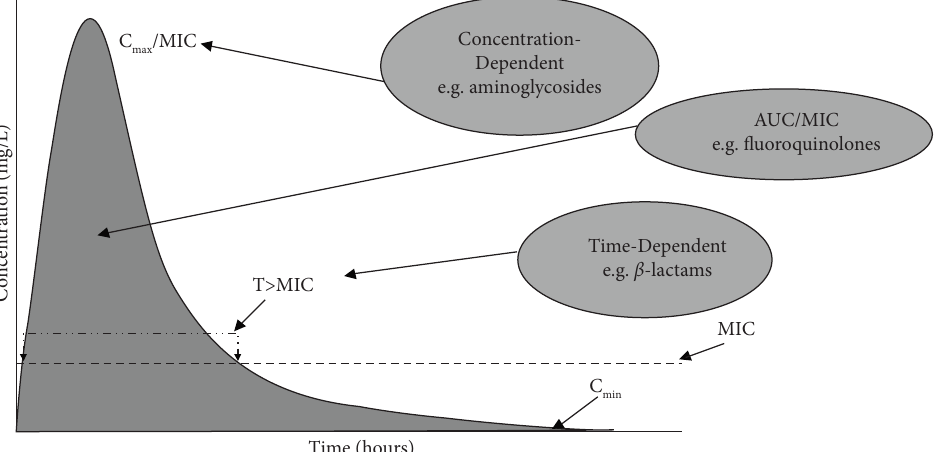
Figure 4: Correlation of the pharmacodynamics of an antimicrobial agent in terms of concentration vs time. C concentration rate ( C max ) by MIC; T > MIC: time T that the antibiotic concentration remains above the minimum inhibitory concentration (MIC); MIC/AUC: ratio of the area under the curve (AUC) of concentration versus time above the MIC. Adapted from Freitas et al. [10]. Table 3: Efcacy of certain antibiotics based on pharmacodynamic properties. Modifed from Roberts and Lipman [9].